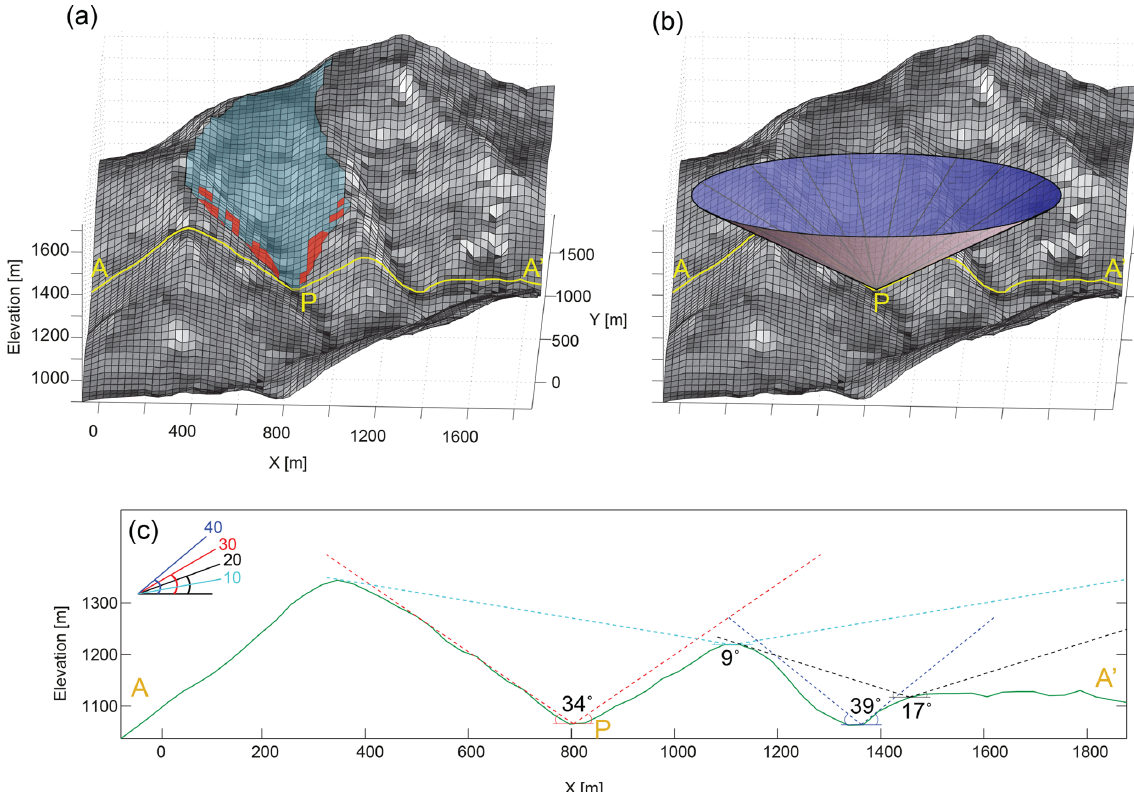
Figure 1. Schematic view of the different topographic metrics tested here. (a) Perspective view of a landscape with each cell shaded according to its local slope from light (steep) to dark (gentle). The upslope contributing area for point P is coloured blue, and the cells steeper than 40 ◦ that have a flow path to P that is never less than 10 ◦ are coloured red. (b) The same perspective view with a cone projected from point P at an angle of 34 ◦ so that the surface of the cone is in places tangent to but never intersects the ground surface, indicating a maximum skyline angle of 34 ◦ for point P. (c) Cross section A–A’ through the landscape (highlighted in yellow on a and b ) with dashed lines showing skyline angles at four example